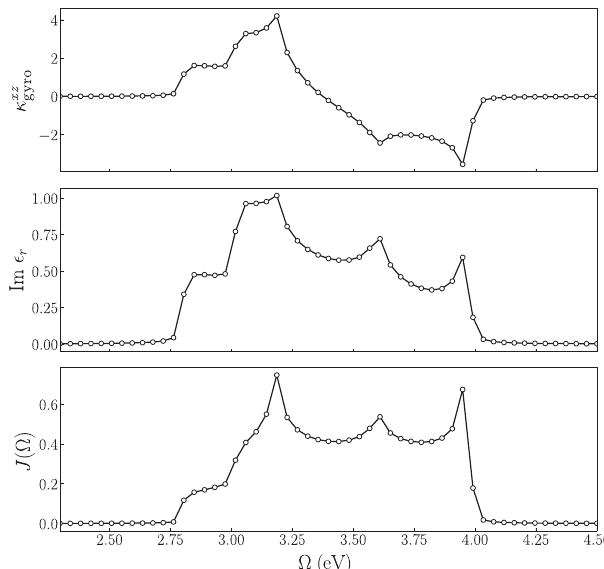
FIG. 2. Frequency dependence of (upper panel) the gyration current coefficient κ xz ( μ A · V − 2 ), (middle panel) dimensionless gyro attenuation coefficient ε , and (lower panel) joint density of r states J ð Ω Þ (eV − 1 ). We adopted q ¼ 1 . 60 × 10 − 19 ð C Þ , ε 0 ¼